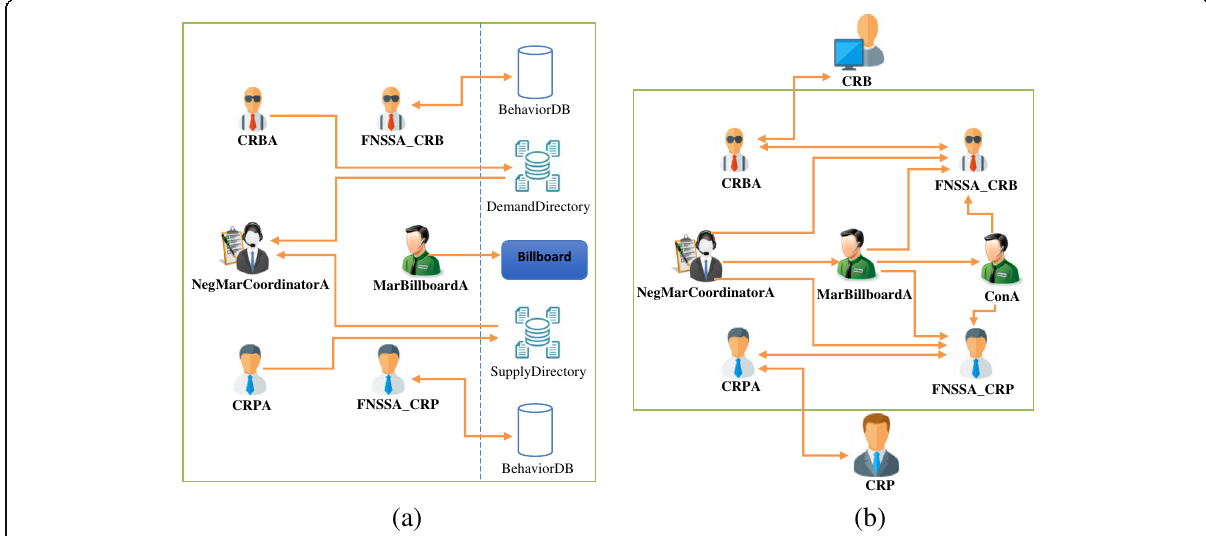
Fig. 1 a The connection between the proposed agents and entities, b The connection between the proposed